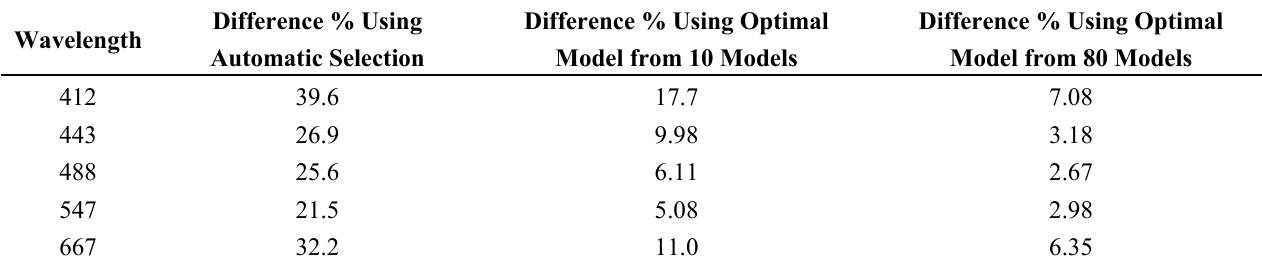
Table 2. MODIS and AERONET-OC L comparison relative percent differences (RPD) at n w visible wavelengths 412, 443, 488, 547, and 667, Martha’s Vineyard, 2010. Automatic aerosol model selection, optimal aerosol model selection using the full set of 80 aerosol models, and optimal aerosol model selection using the confined set of 10 aerosol models (representing size fraction) after the relative humidity has been determined from